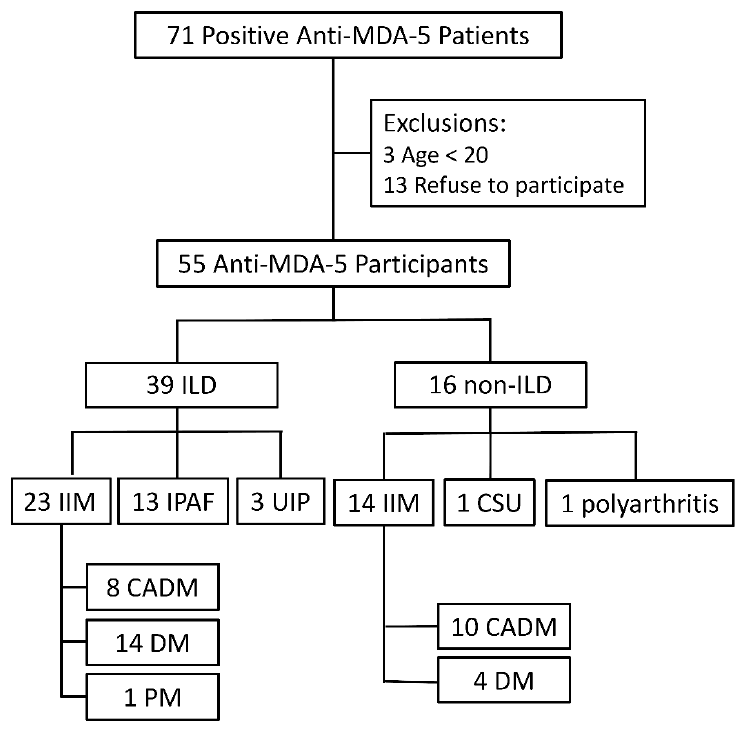
Figure 2. Patient classification by the presence of ILD and IIM